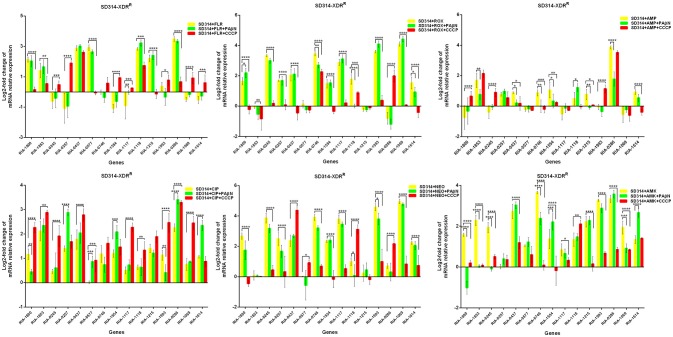
Quantification of the relative mRNA expression levels of a panel of EPGs in SD314 strains. Strains were grown in the presence of half MIC of each antibiotic; CCCP (5 μg/mL) and PAβN (40 μg/mL) showed no effects on the growth of R. anatipestifer isolates. The MICs of the antibiotics and EPIs were determined for each strain and are presented in Table 4. Change in the level of transcription of EPGs was measured as fold change normalized to recA gene expression and was subsequently calculated as log2-fold change that is relative to the untreated cell culture. Levels of significance were set as follows: *P < 0.05 was considered statistically significant, and **P < 0.01, ***P < 0.001, and ****P < 0.0001 were all considered highly significant.